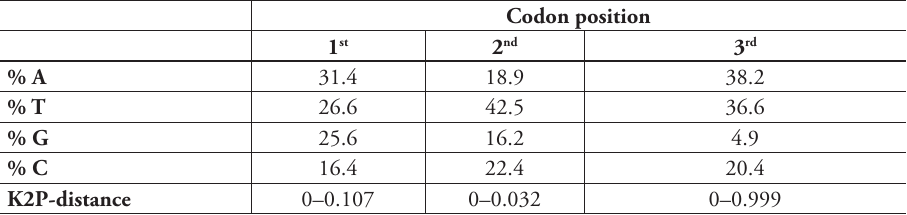
Table 3. Nucleotide composition and K2P-distances at each codon position of the 670 bp COI